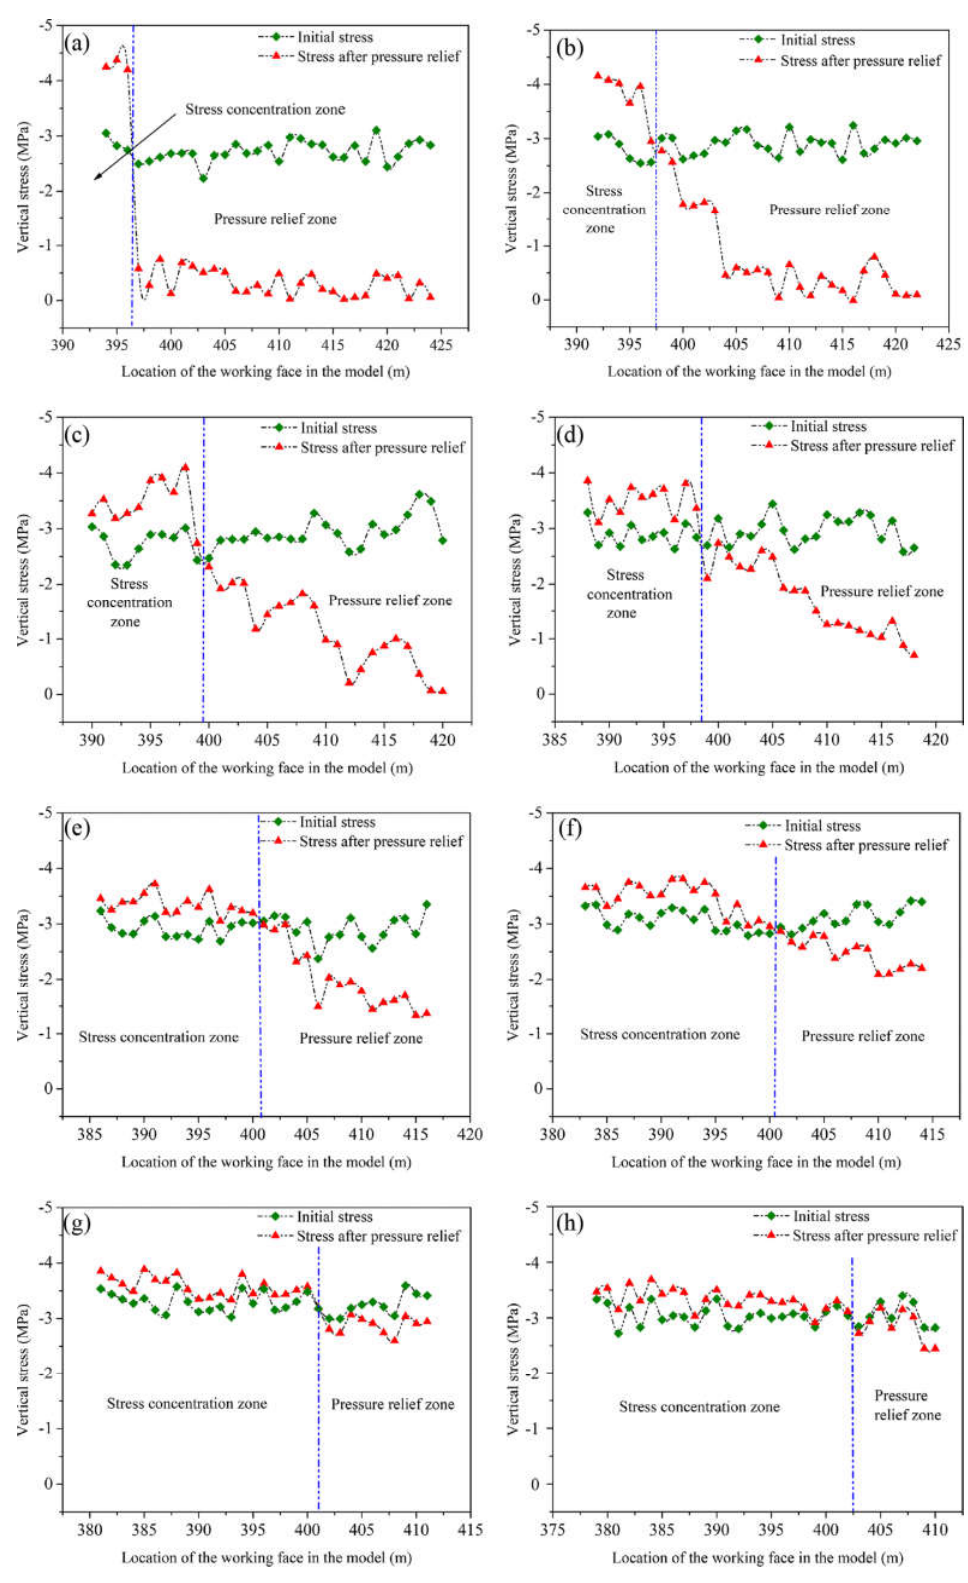
Figure 7. Vertical stress monitoring results during the mining of the 5th slice: ( a ) 2 m below the goaf; ( b ) 5 m below the goaf; ( c ) 8 m below the goaf; ( d ) 11 m below the goaf; ( e ) 14 m below the goaf; ( f ) 17 m below the goaf; ( g ) 20 m below the goaf and ( h ) 23 m below the goaf.